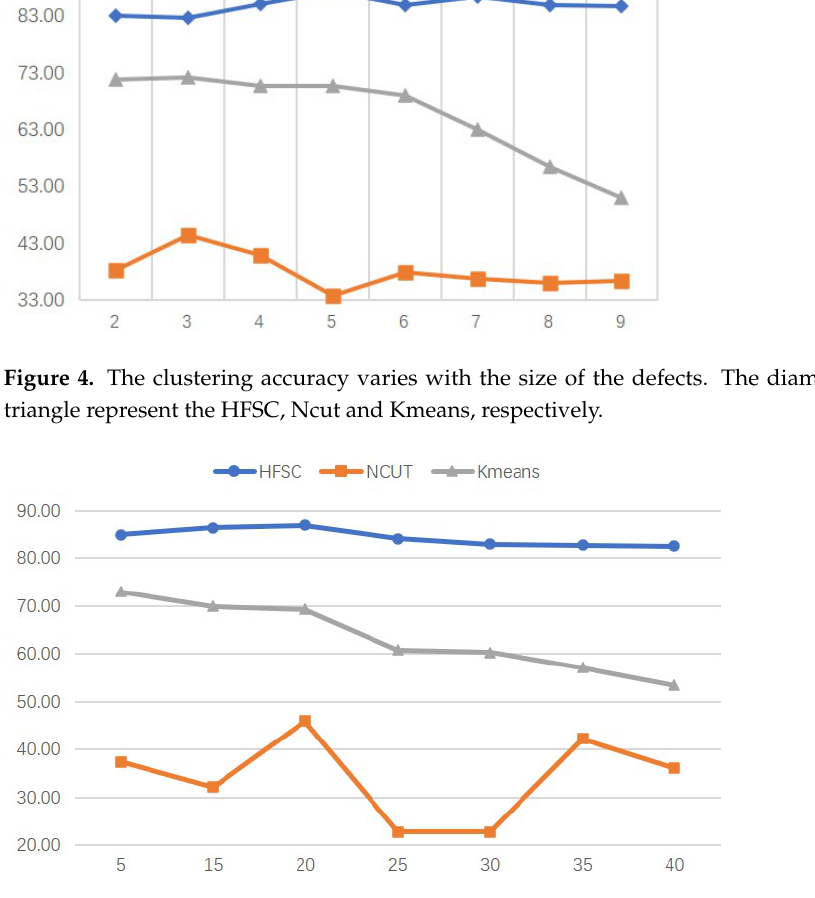
Figure 5. The clustering accuracy varies with the number of the defects. The diamond, square and triangle represent the HFSC, Ncut and Kmeans,